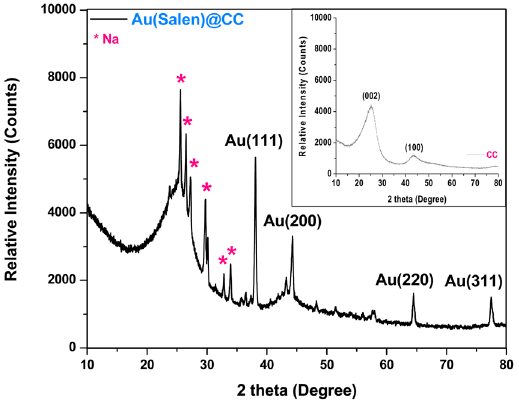
Figure 2. Wide-angle powder XRD patterns of CC and Au(Salen)@CC